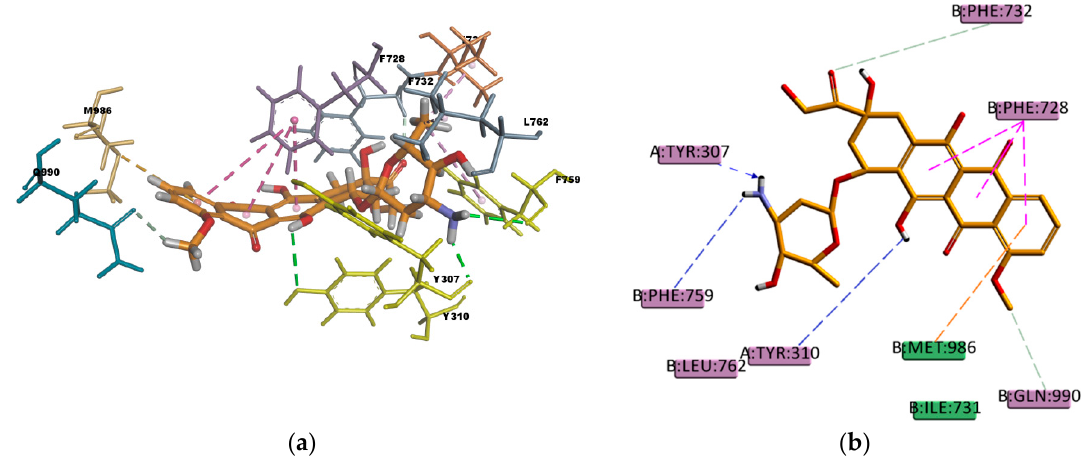
Figure 16. Doxorubicin (DOX) top-ranked pose obtained with CDOCKER algorithm. ( a ) 3D view of DOX interactions in the binding pocket. Green dotted lines represent conventional hydrogen bond interactions, light-green dotted lines represent carbon hydrogen bond interactions, light-rose dotted lines represent hydrophobic interactions, pink dotted lines represent π – π T-shaped interactions, and the orange dotted line represents a π –sulphur interaction. Residues F759, Y307, and Y310 involved in conventional hydrogen bond interaction are highlighted in yellow; ( b ) 2D interaction diagram of DOX with h P-gp interacting residues. Green dotted lines represent conventional hydrogen bond interactions, light-green dotted lines represent carbon hydrogen bond interactions, pink dotted lines represent π – π T-shaped interactions, and the orange dotted line represents a π –sulphur interaction with the residue M986.